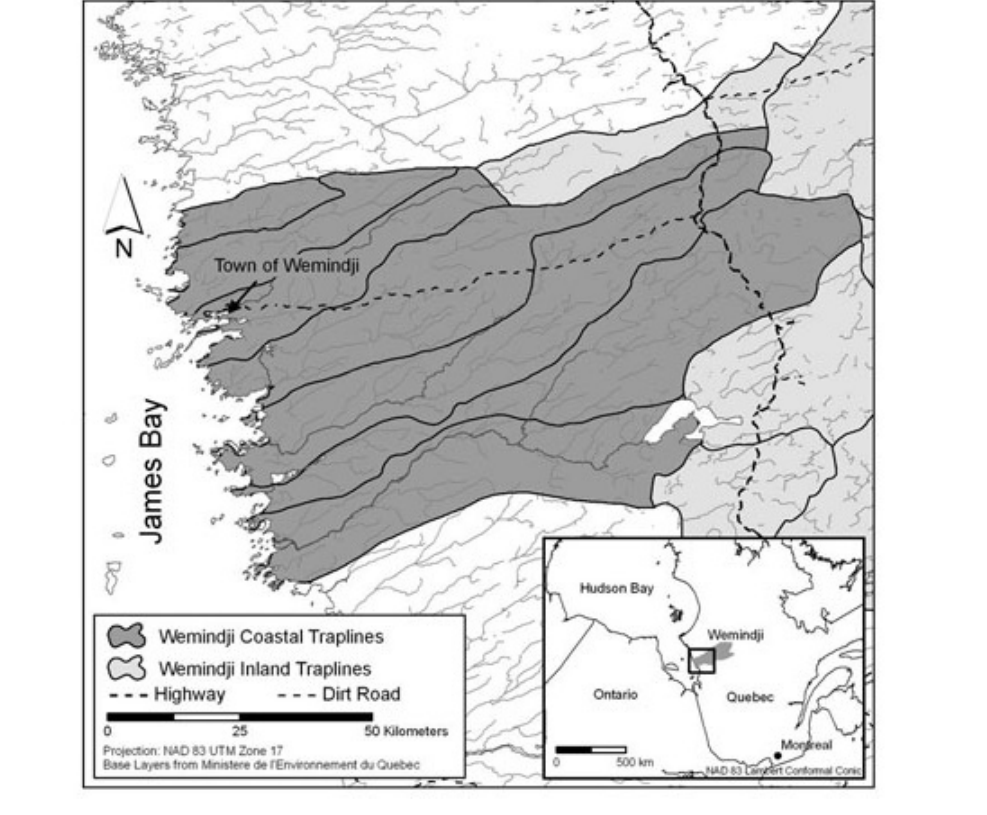
Fig. 1 . Location map of the Wemindji coastal hunting territories plus regional